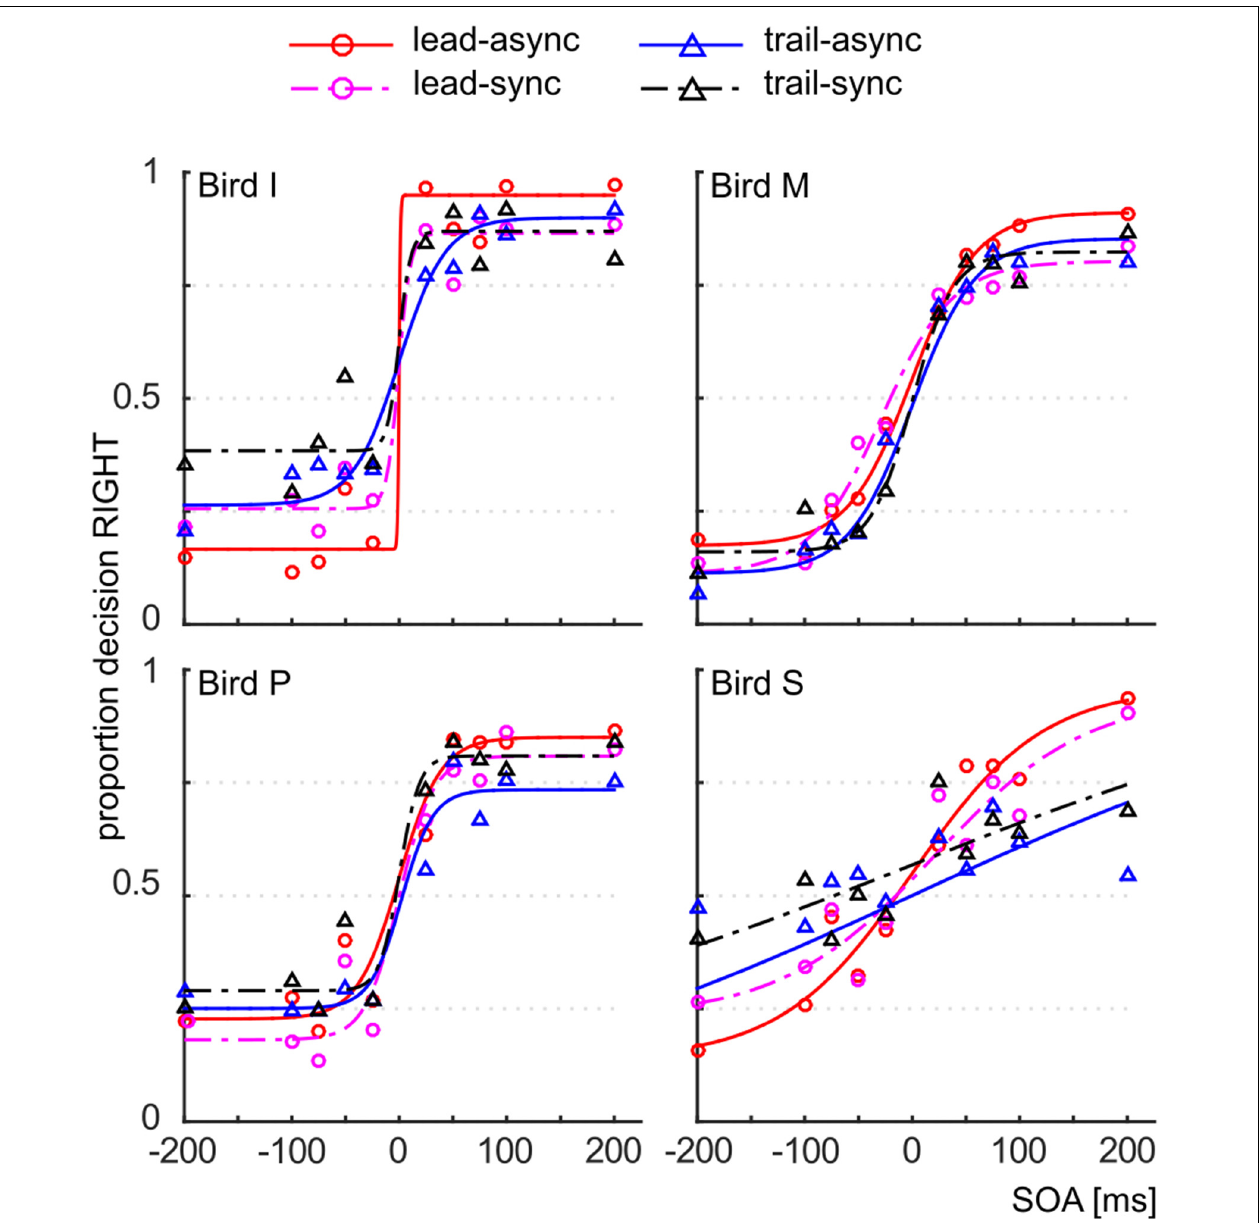
FIGURE 2 | Correct responses. Proportion decision to the right as a function of the SOA, for the different test conditions. Data are shown as symbols, the fitted PMFs as line graphs. Red circle and solid line: lead-async; magenta circle and dashed line: lead-sync; blue triangle and solid line: trail-async; black circle and dashed line: